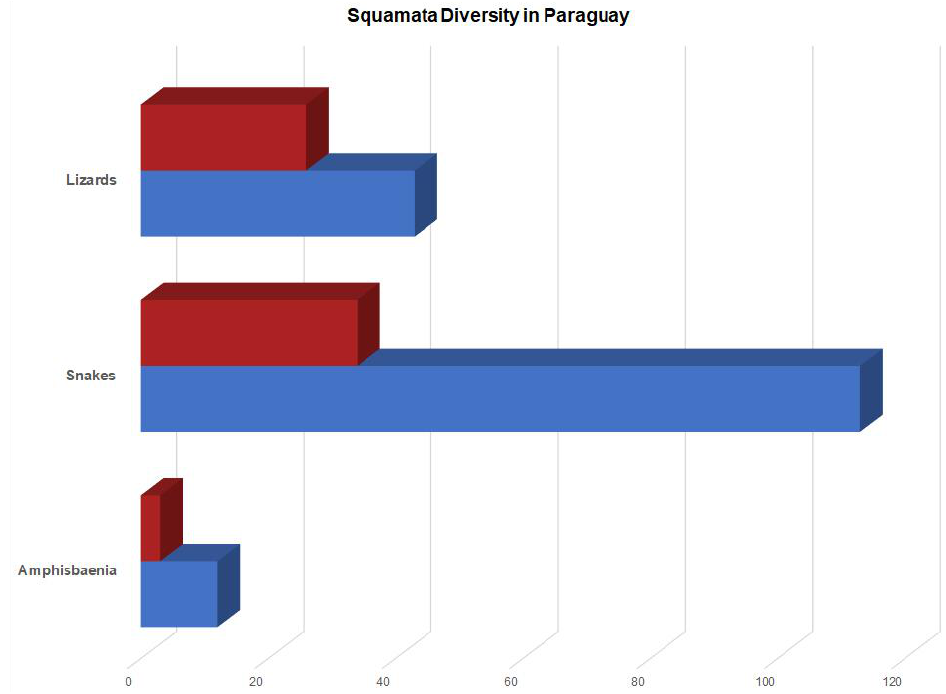
Figure 5. Comparison between known diversity of Paraguayan Squamata (blue bars) vs. diversity of sampled taxa for this study (red bars).